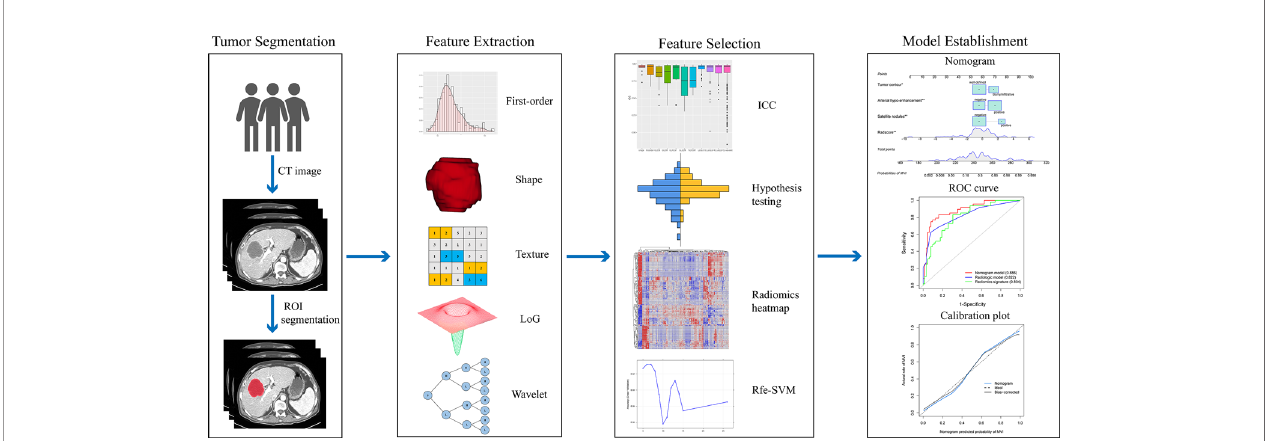
FIGURE 2 | Work fl ow for the radiomics process. After CT images were acquired, segmentation of the tumor was performed. The extracted radiomics features include fi rst-order, shape, Laplacian of Gaussian, texture, and wavelet features. A four-step approach was performed for feature dimension reduction. Intra- and inter-class correlation coef fi cient (ICC) was used to evaluate the reproductivity of features. Values lower than 0.8 were eliminated. Student ’ s t-test or Mann – Whitney-U test was performed to fi nd the differential radiomics features. A heatmap shows the Pearson correlation coef fi cients matrix among radiomics features. Rfe-SVM was applied to develop the radiomics signature. A nomogram was constructed by integrating independent radiological predictors and portal phase image radiomics signature. The nomogram and radiologic model ’ s discriminative ability were compared with the ROC curve analysis and quanti fi ed by the AUC. The calibration curve demonstrated good agreement between the actual and nomogram predicted probabilities.